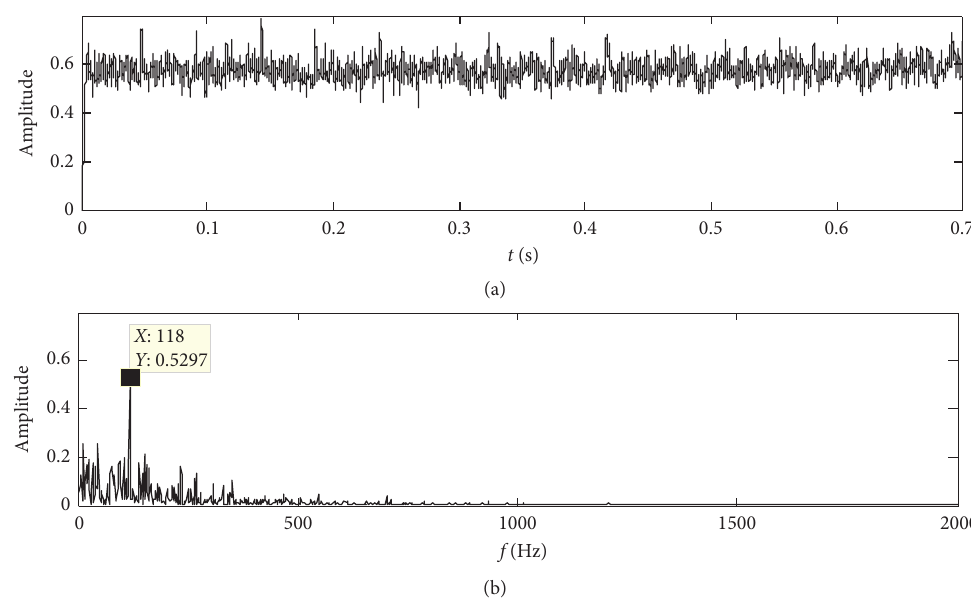
Figure 14: Output signal of the piecewise linear system.